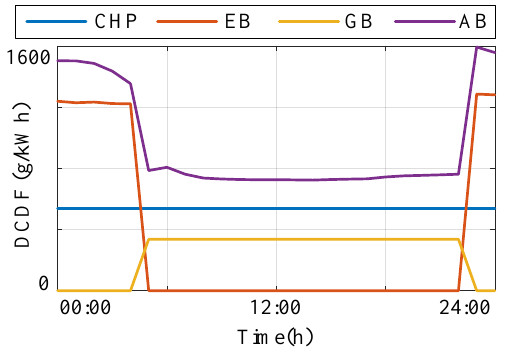
Figure 7. The DCDF values of various EH devices.